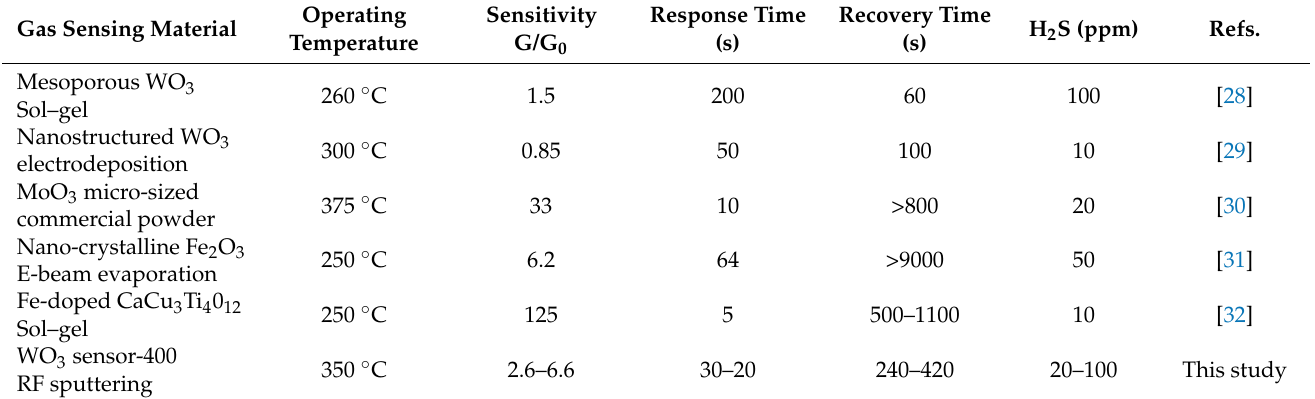
Figure 9. Dynamic response of sensor-400 under different concentrations of H 2 S at 350 °C; on: H 2 S injected; off: air injected. Table 3. Comparison of sensing thin-film materials for H 2 S